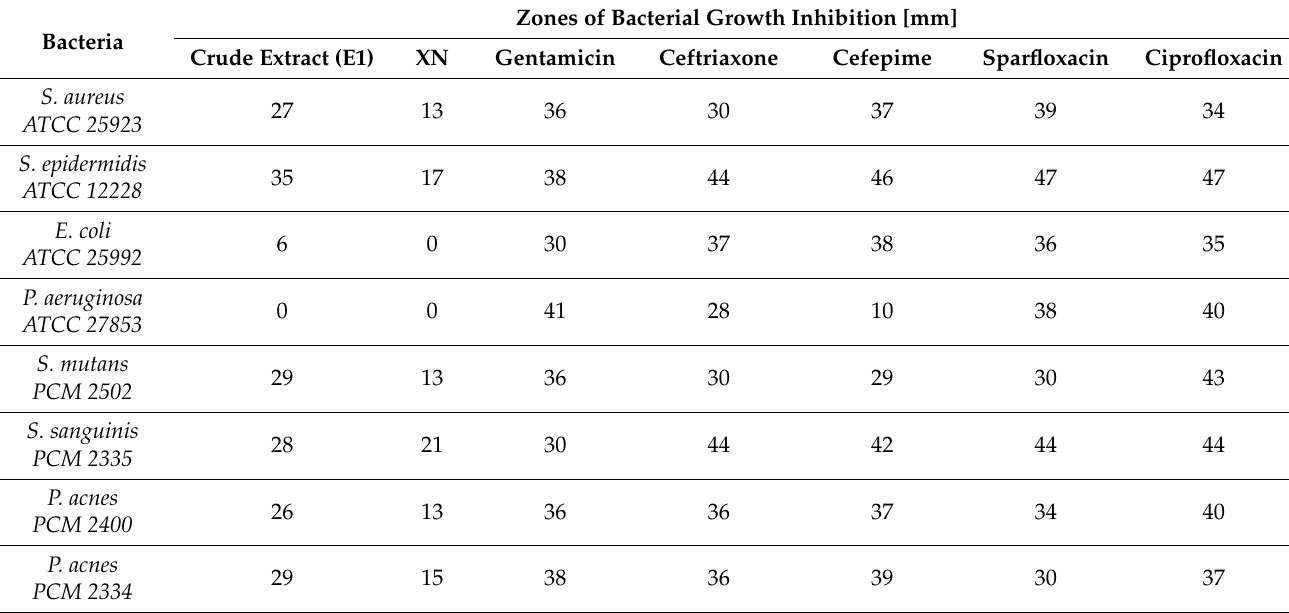
Table 3. Zones of bacterial growth inhibition of compounds from Marynka hop variety and selected antibiotics. Bacteria